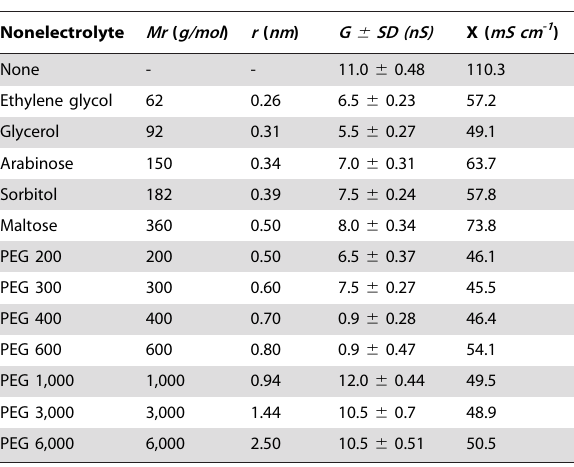
Table 1. Average single-channel conductance of P66 in the presence of different nonelectrolytes (NEs) in the bath solution.